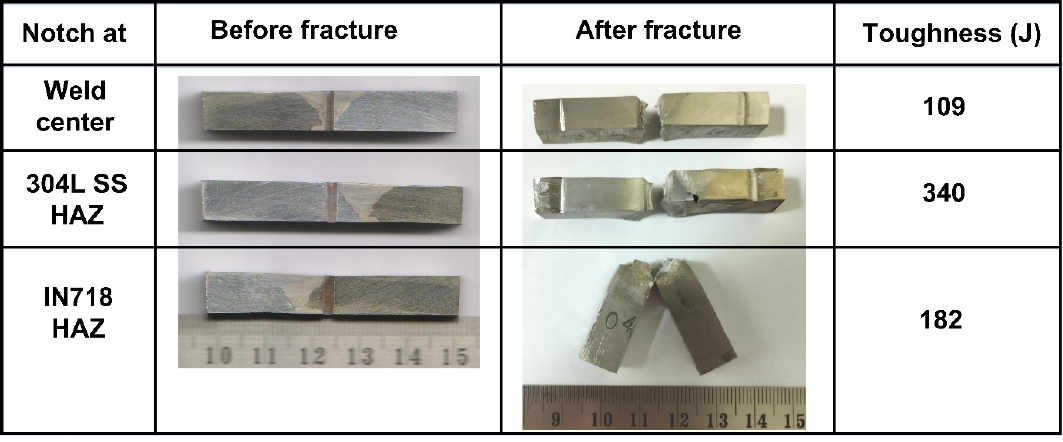
Table 3. Impact test specimen and test results.